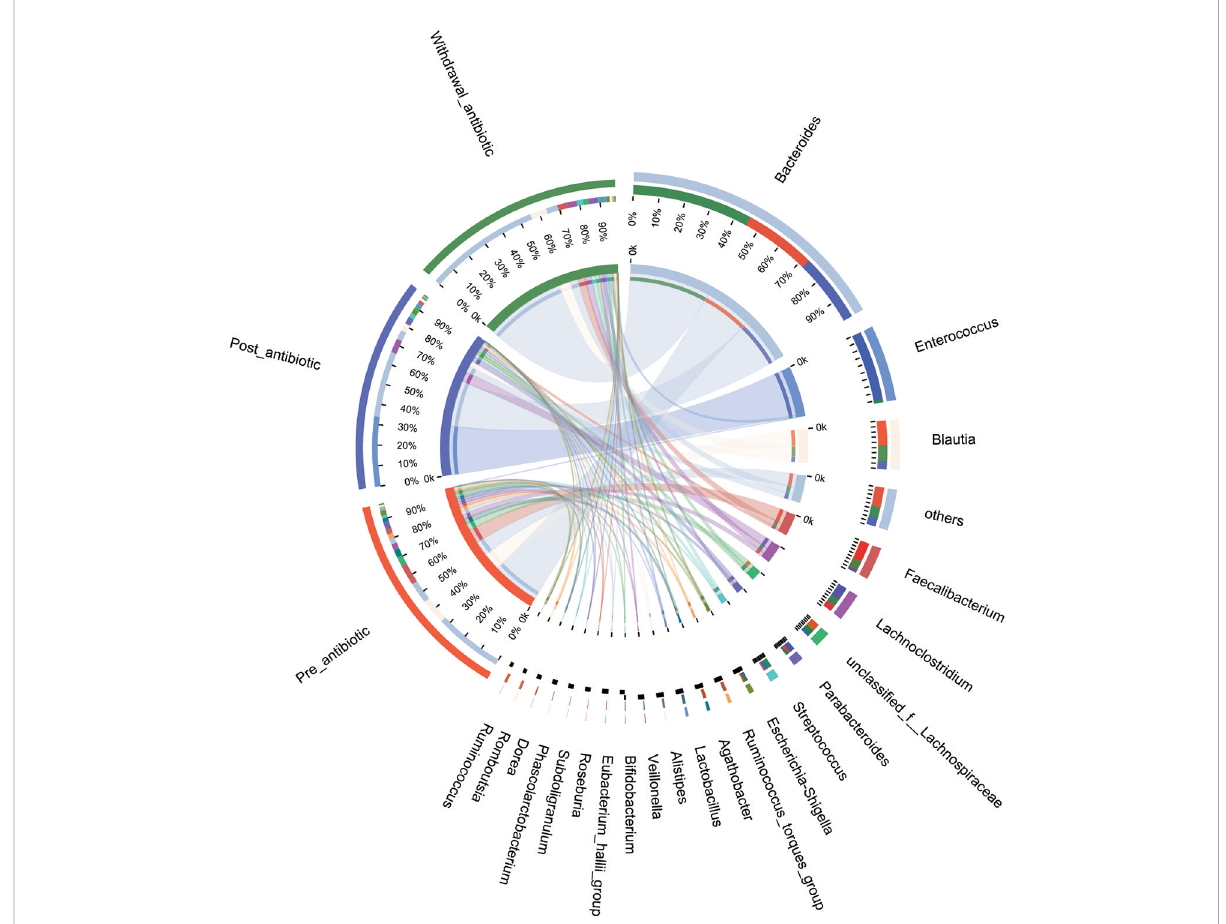
FIGURE 3 The distribution of dominant bacteria of the sample in each group for the antibiotics group.